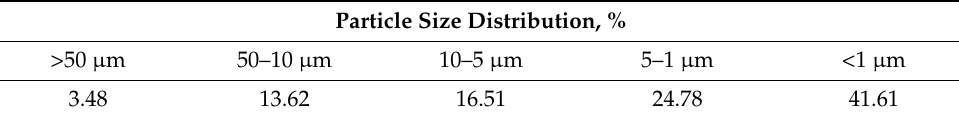
Table 2. Granulometric composition of the studied clay.